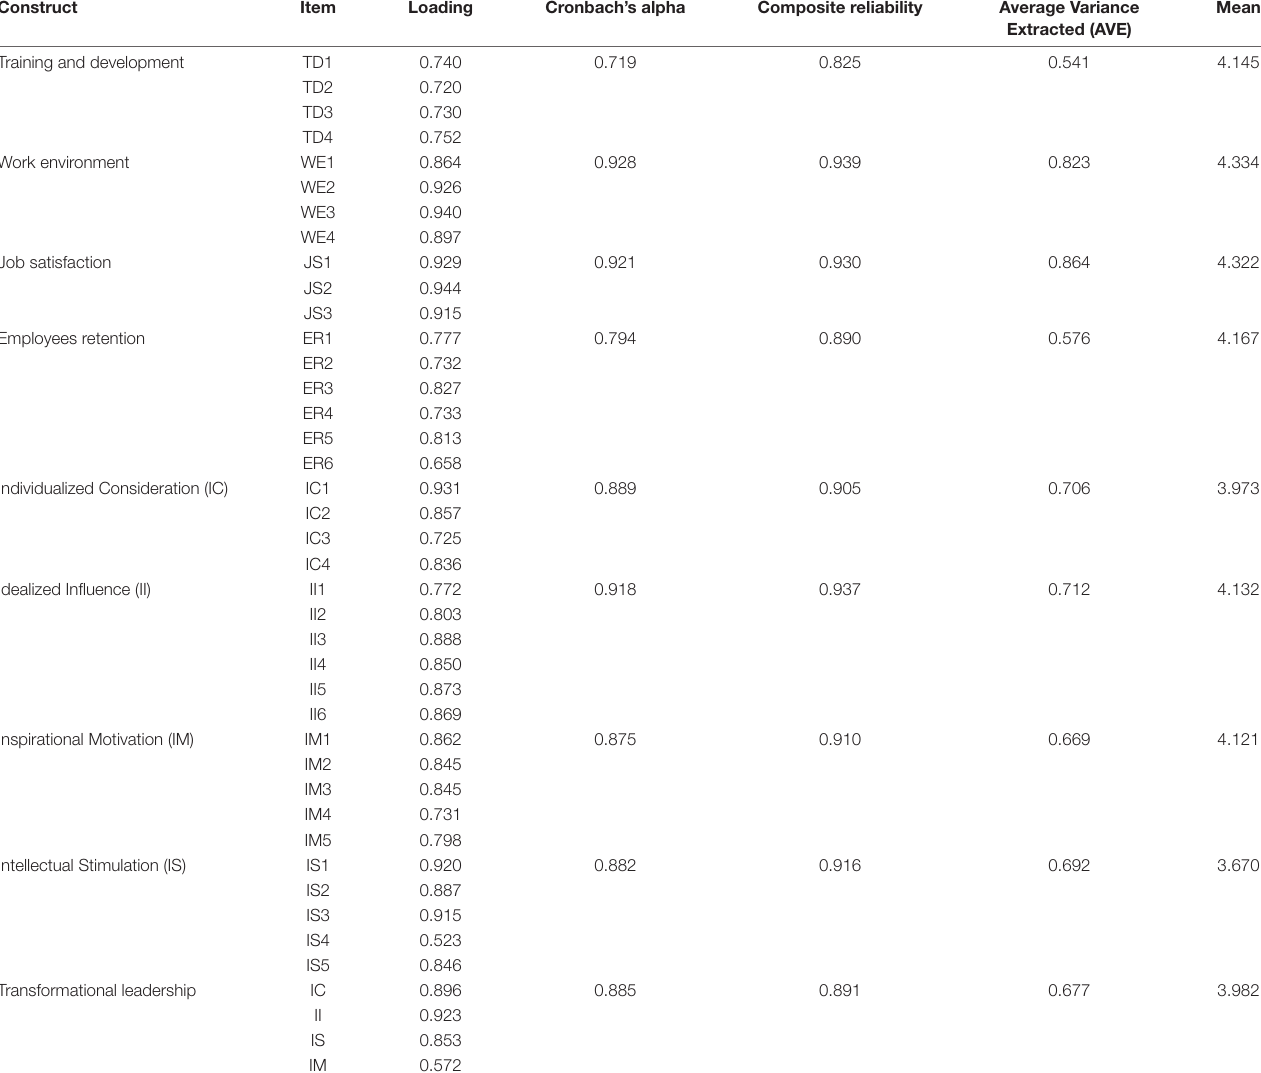
TABLE 1 | Factor loadings, reliability, AVE, and mean values.